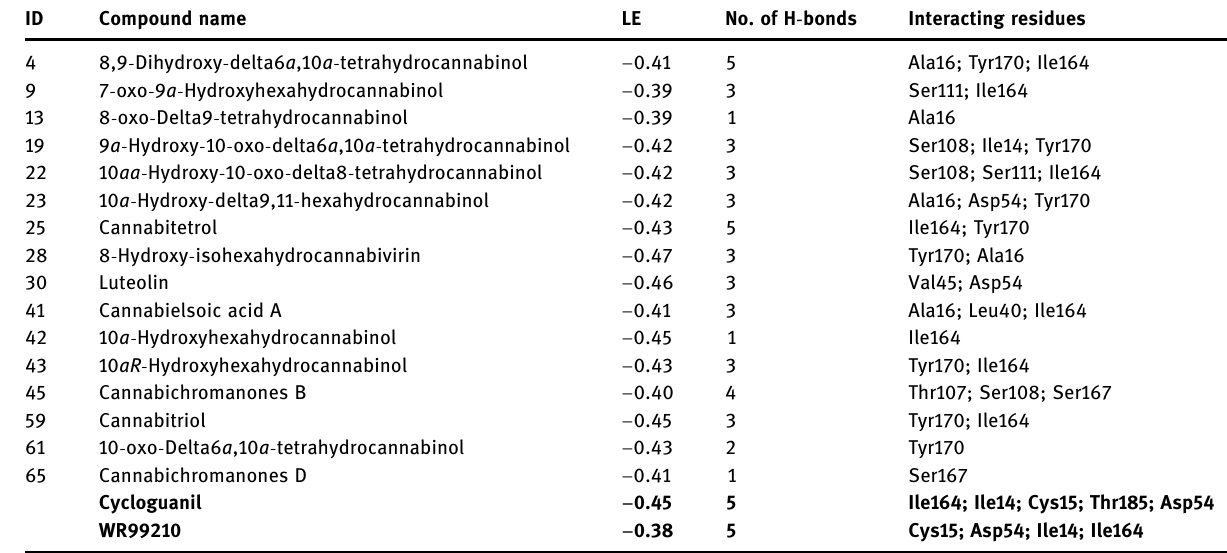
Table 3: The LE and hydrogen bond interactions between 16 potential compounds and pfDHFR -